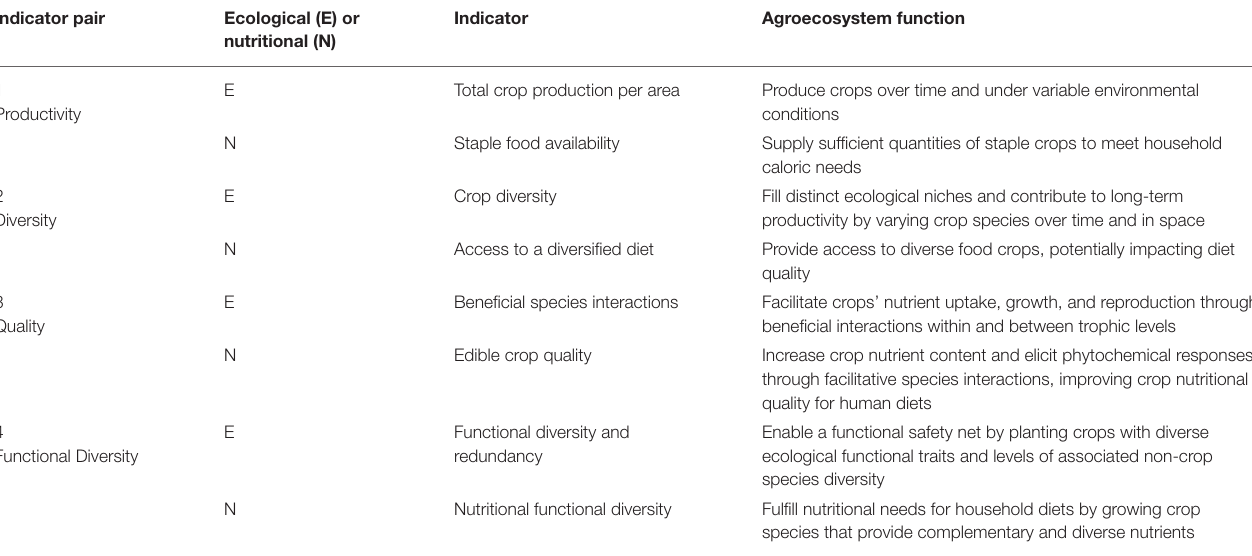
TABLE 1 | Indicator framework for ecological and nutritional functions of agroecosystems. Indicator